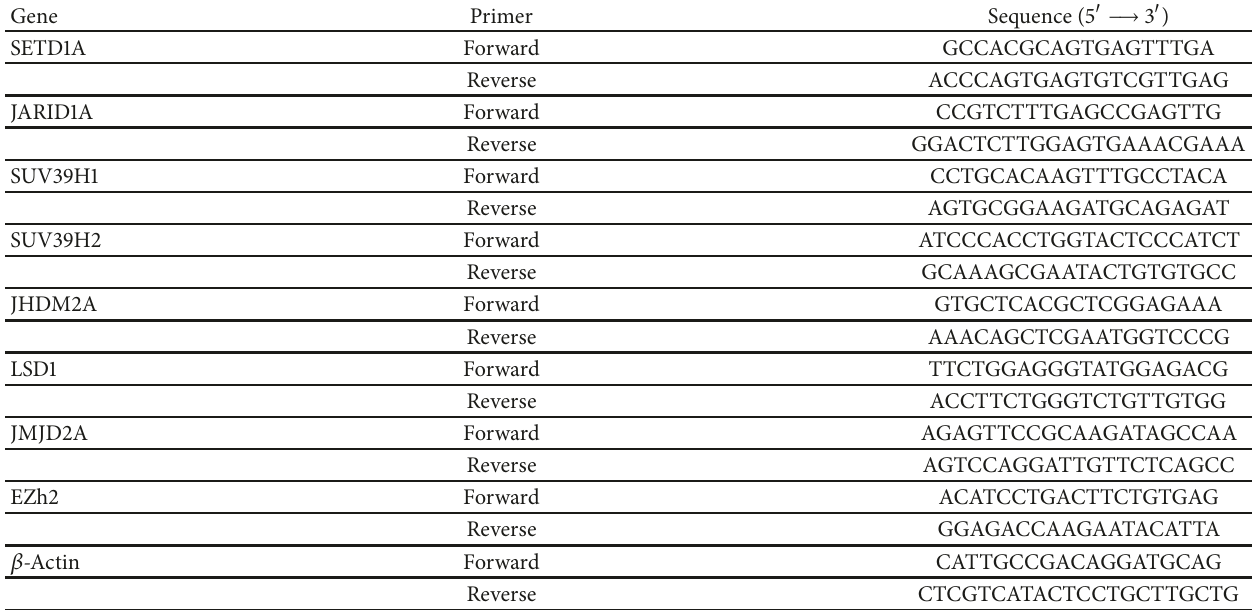
Table 1: Primer sequences used for